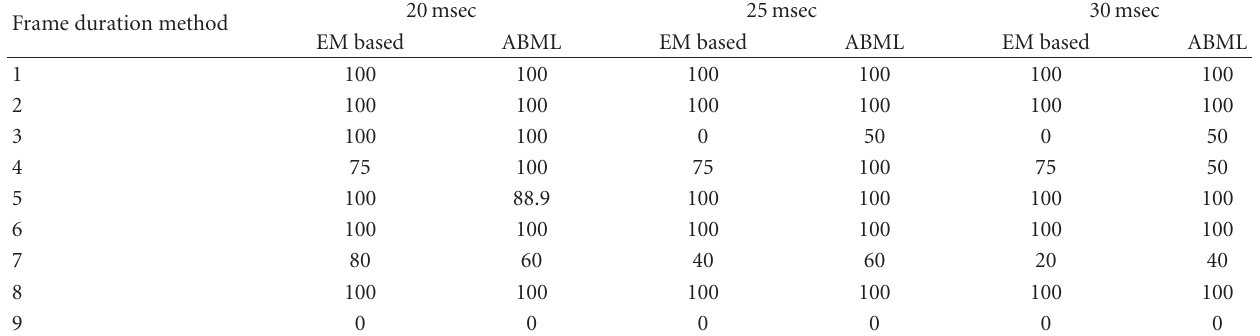
Table 2: Obtained accuracy rate for multipathology classification task (%).